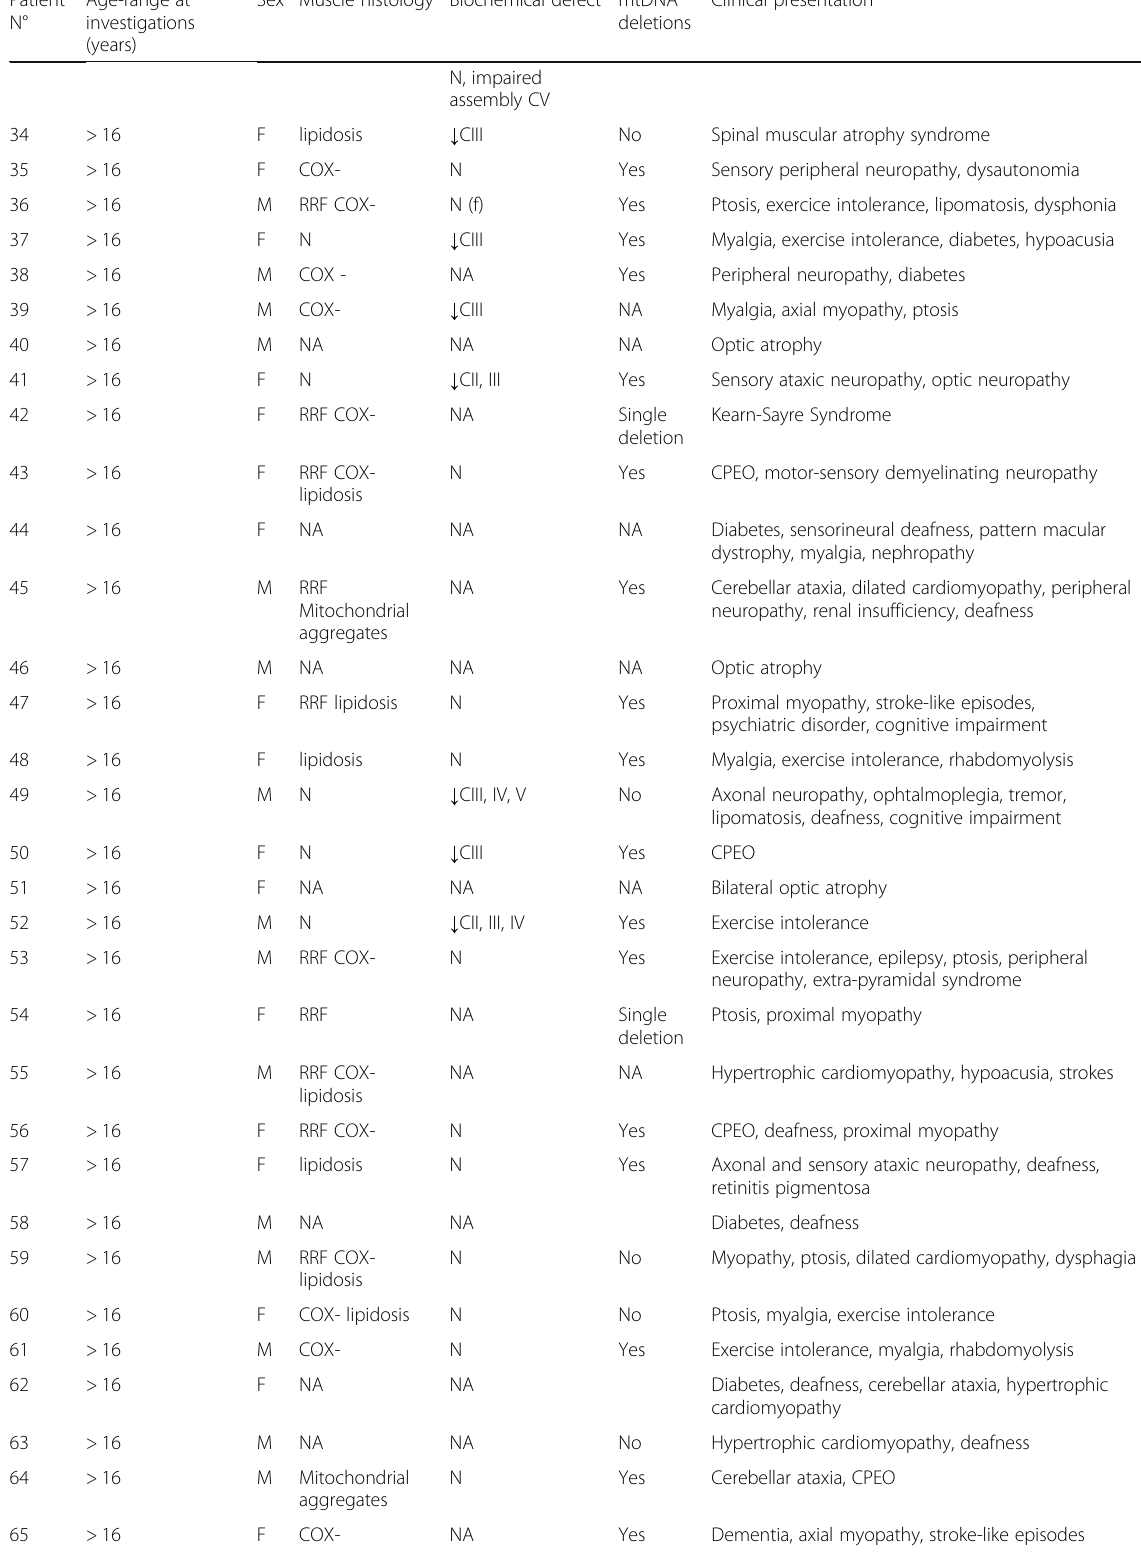
Table 1 List of the patient cohort (Continued) Patient